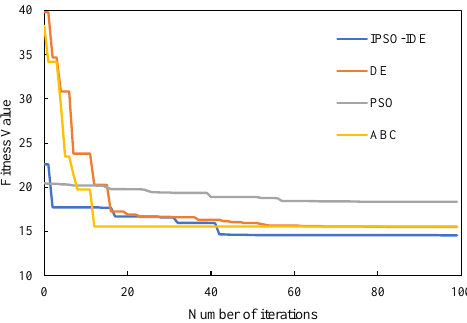
Figure 10. Convergence curves of optimal fitness values based on different algorithms in environment 2. Table 5. Path-planning results of different algorithms in environment